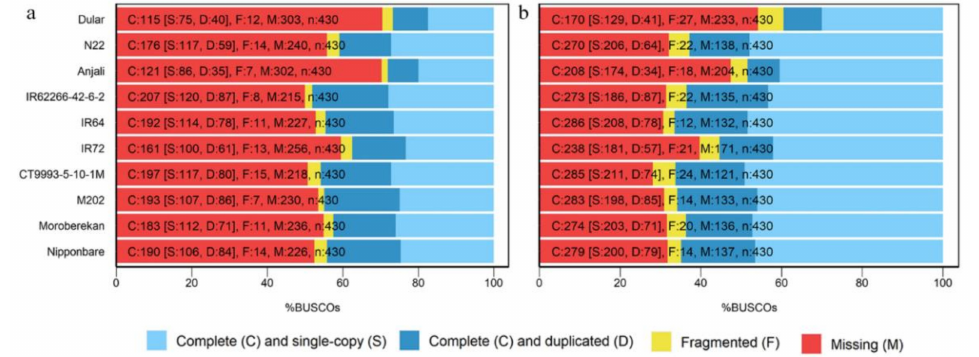
Figure A1. Benchmarking Universal Single-Copy Orthologs (BUSCO) assessment results for the collapsing tools cogent ( a ) and cDNA cupcake ( b ).